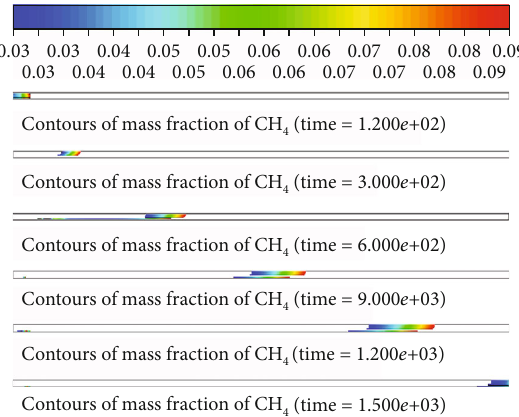
Figure 10: Increasing trend of CH concentration in the tunnel (a) 5 min, (b) 10min, (c) 15min, and (d) 20 min. 4